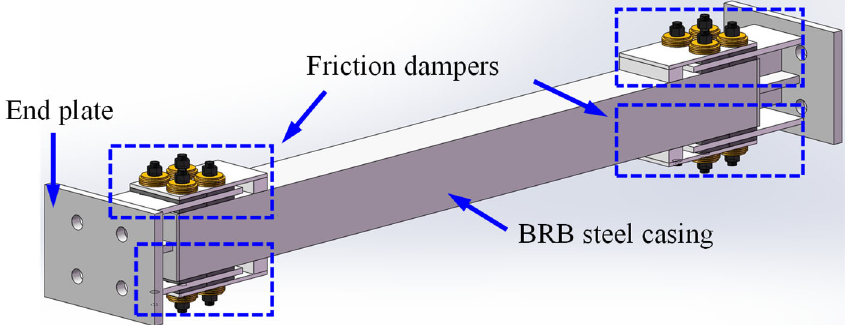
Figure 3. Schematic of the proposed FBRB.